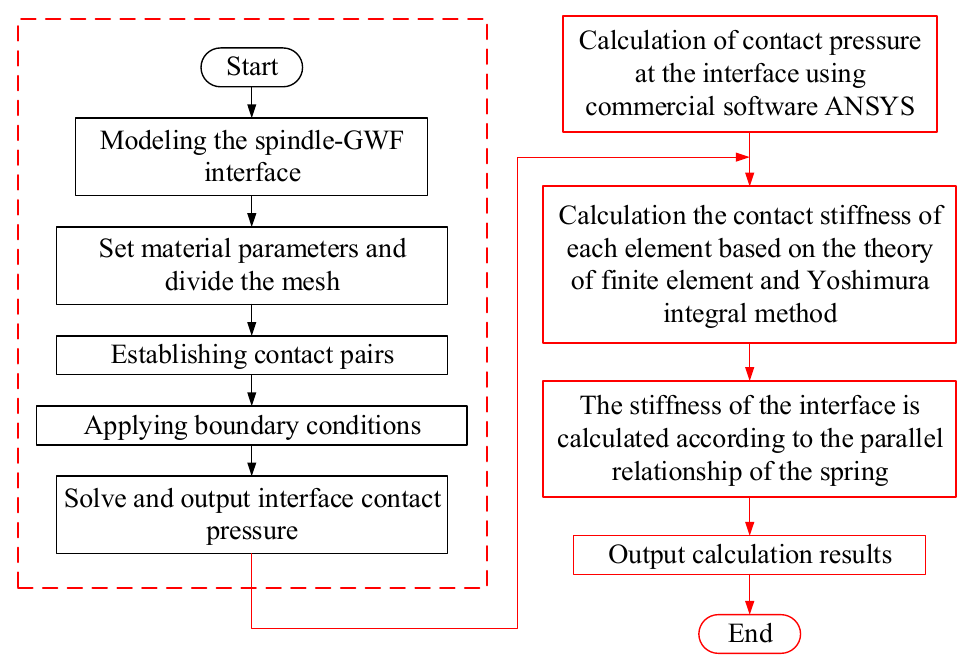
Figure 5. Flow chart of contact stiffness calculation of the spindle–GWF interface.